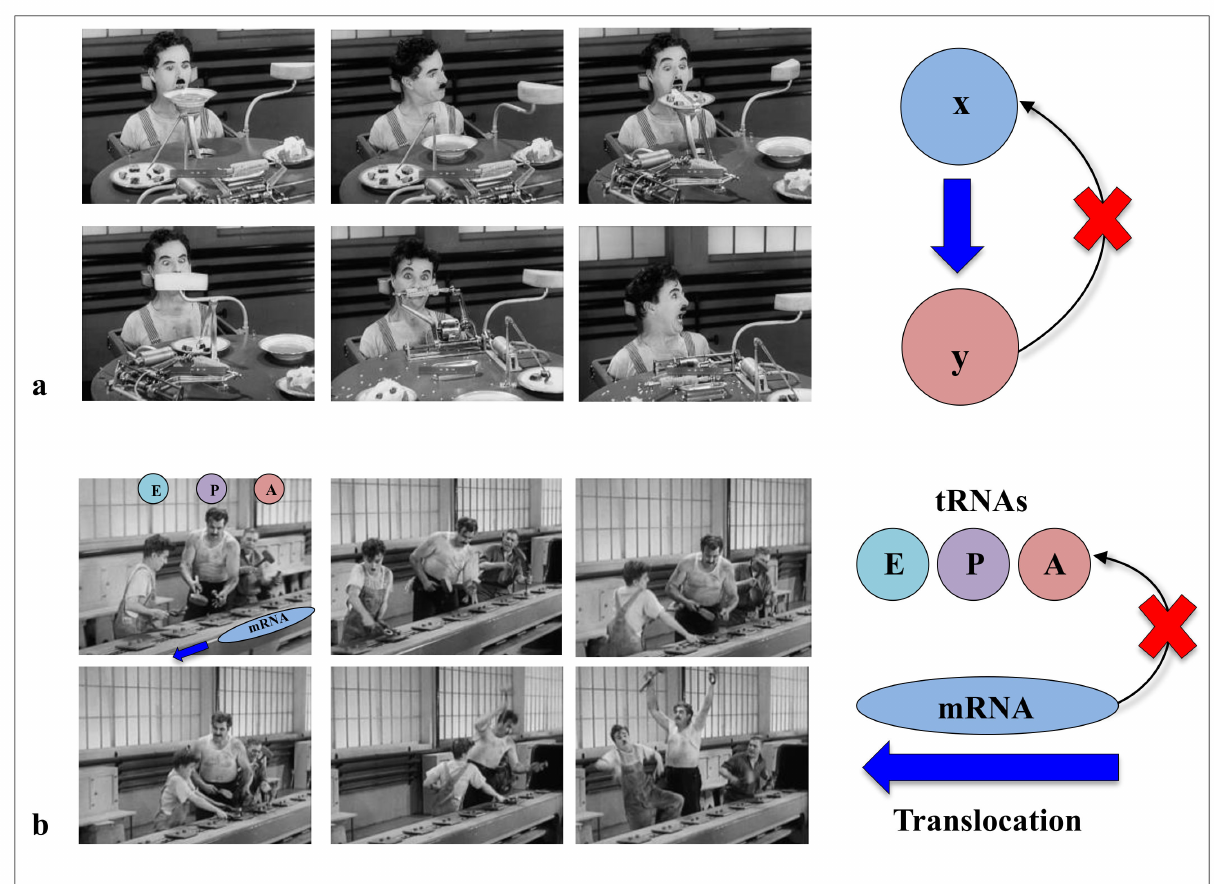
Figure 1. “Feeding without feedback”. In his movie “Modern Times”, Chaplin illustrates the limits of the machine metaphors in biology. ( a ) A “machine” is supposed to feed the worker without feed-back. ( b ) The scene showing three workers who, in order to screw in bolts, have to follow the rapid and uncontrollable movement of a conveyor belt illustrates in a suggestive way the difficult task of the three tRNAs (A, P and E) in a "machine" ribosome without any feedback process between the different